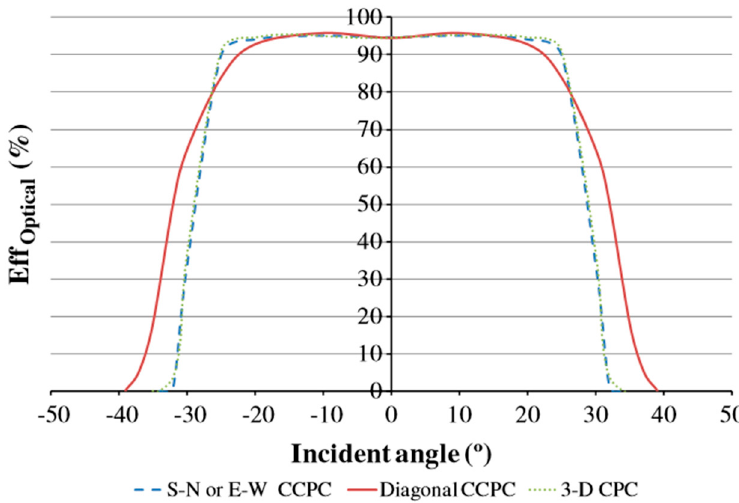
Figure 1. Variation of the optical efficiency as a function of the incidence angle of the incoming rays. Reproduced with permission from [7], Elsevier, 2013.